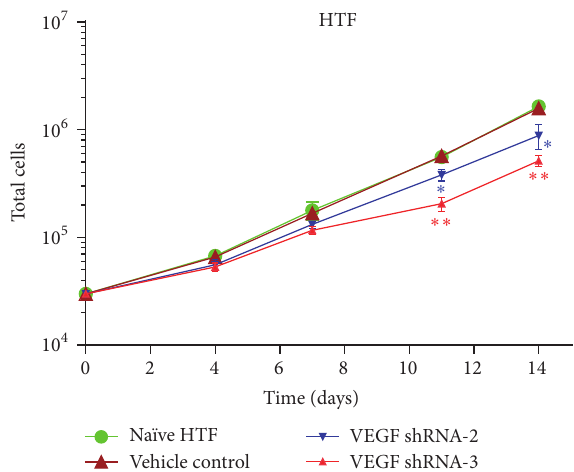
Figure 3: Cell growth curves. Total cell numbers were counted at 4, 7, 11, and 14 days after addition of DOX to cultures. Curves represent total cell numbers of na¨ıve HTF cells, vehicle transfected HTF cells, VEGF-shRNA-2 transfected HTF cells, and VEGF-shRNA-3 transfected HTF cells. ∗ means 𝑝 value < 0.5 compared to vehicle control. ∗∗ means 𝑝 value < 0.1 compared to vehicle